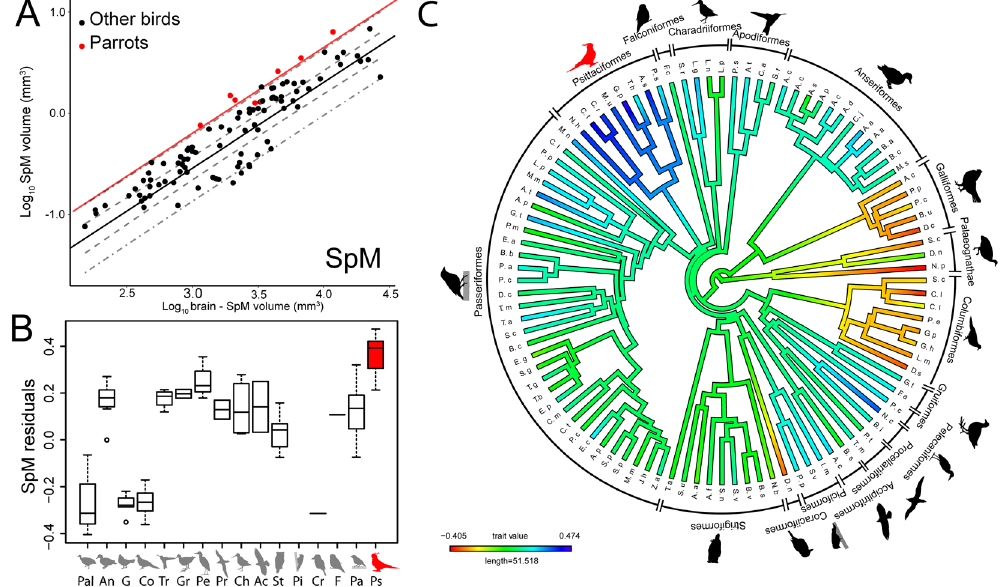
Figure 2. Relative size of the medial spiriform nucleus (SpM). ( A ) The log-transformed volume of the SpM is plotted as a function of the brain volume minus the volume of SpM. Black solid line represents the regression line for all species obtained from a PGLS (see methods). The red line shows the regression line for parrots also obtained from a PGLS. Confidence intervals are presented as dashed lines, prediction intervals as dash and dotted lines in grey. ( B ) Box plots show the relative size of SpM for each avian orders represented in this study. Parrots (Psittaciformes), are shown in red. Values shown in the box plots are derived from the residuals from PGLS of the log of the volume of each nucleus against the brain volume (see methods, panel A). The solid horizontal line represents the median, the two boxes represent the limits of the second and third quartiles and the whiskers (dashed vertical lines) represent the limits of the first and fourth quartiles. The open circles represent outliers, which are defined as those outside the first or fourth quartile by a magnitude of 1.5X the inter-quartile range. ( C ) Ancestral character estimates for relative SpM volumes plotted onto an avian phylogeny. This method uses ancestral character estimation to visualize historical character states for SpM volumes (plotted as a continuous trait) along the branches of a tree. The trait mapped was the relative size of SpM as in panel B. An = Anseriformes, Ch = Charadriiformes, Co = Columbiformes, F = Falconiformes, G = Galliformes, Gr = Gruiformes, Pa = Passeriformes, Pal = Paleognaths, Pe = Pelecaniformes, Pi = Piciformes, Pr = Procellariiformes, Ps = Psittaciformes, St = Strigiformes, Tr =